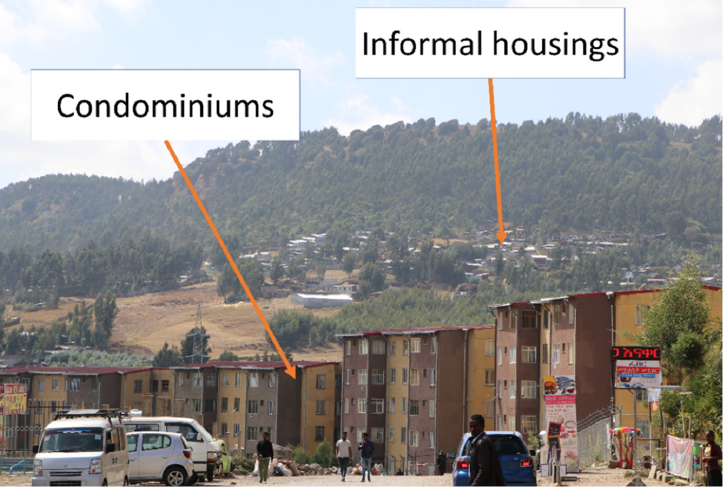
Figure 18. Informal housing settlements near condominium expansion areas within the Yeka Abado neighborhood. Source: captured by A.T.W. on 13 January